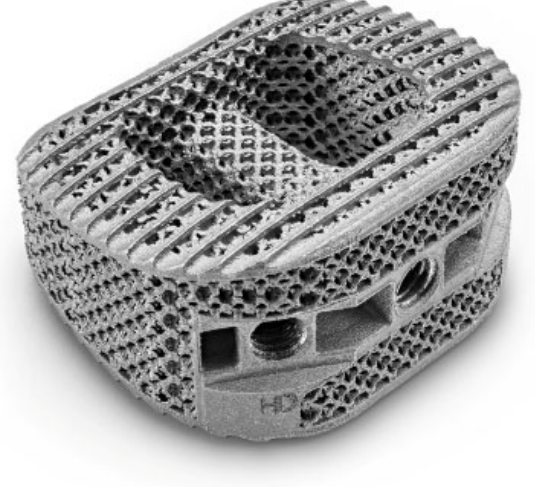
Figure 6. Lumbar interbodies with Hive TM mesh lattice cells. Reprinted with permission from NanoHive (2022) [122].